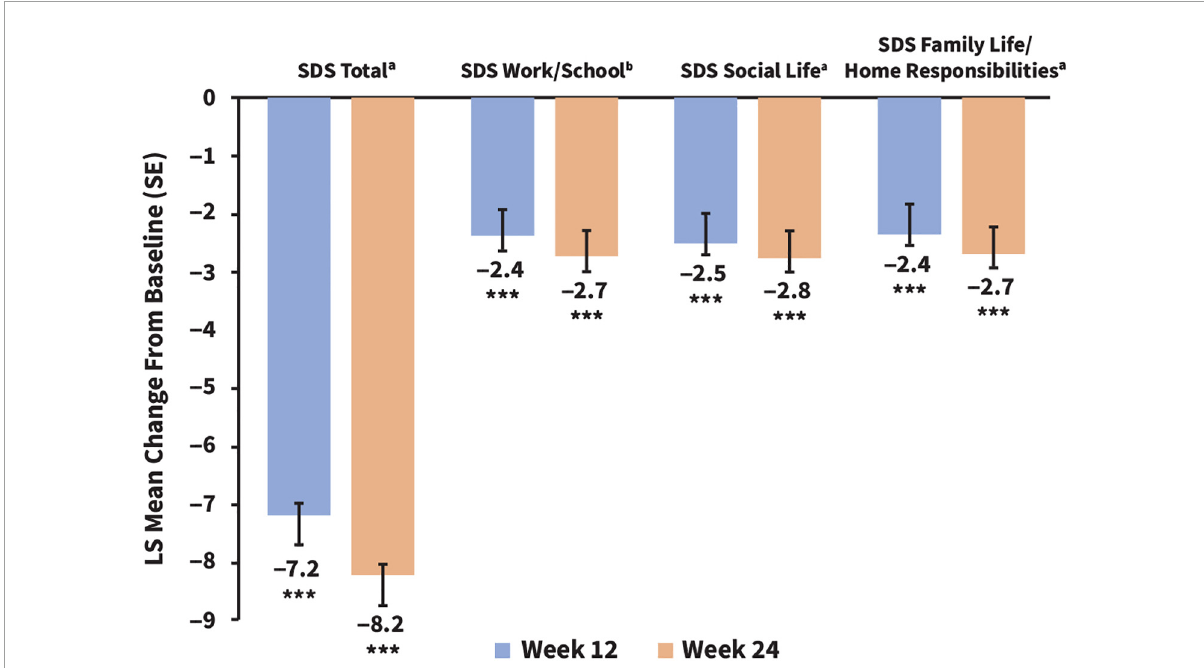
FIGURE1 Changes in adjusted LS mean SDS total scores and subscores from baseline to weeks 12 and 24. *** p < 0.001. All statistical comparisons were significant vs. baseline. SDS LS mean baseline scores (CI) for comparison were as follows: total, 19.58 (18.78–20.38); work/school, 6.28